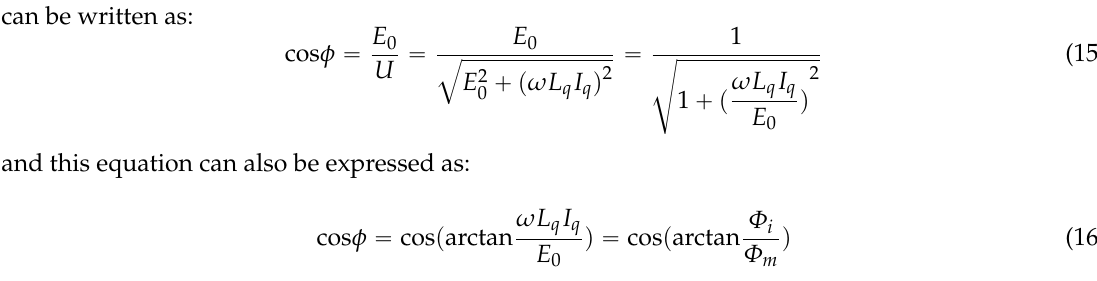
Table 3. Power factor based on different